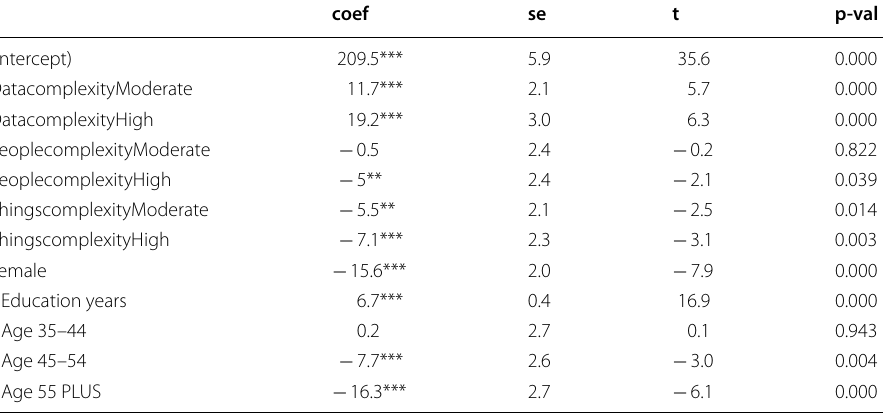
Table 13 Regression results for Denmark. Source: PIAAC 2012, DOT index, ISCO-08 codes